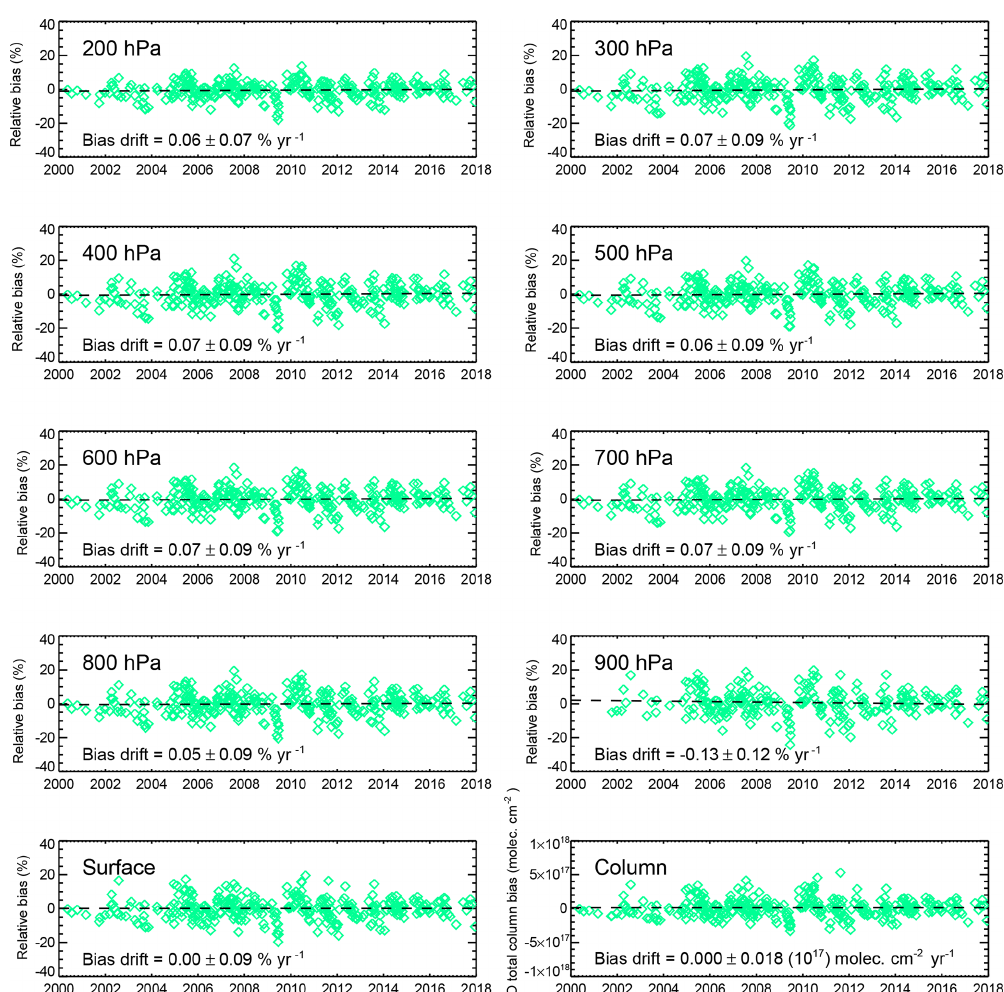
Figure 9. Retrieval bias drift for V8 NIR-only products based on the NOAA flask